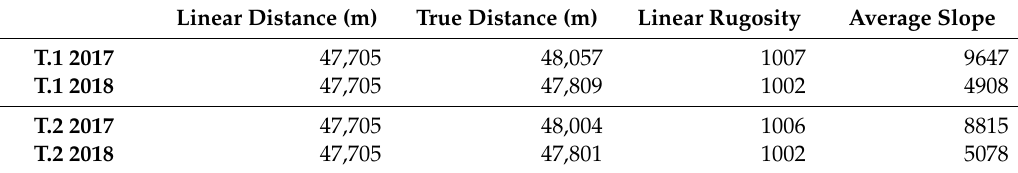
Table 4. Variation in linear rugosity and average slope between years along the transects T1 and T2 in Area 2 (Figure 8). Linear Distance (m) True Distance (m) Linear Rugosity Average